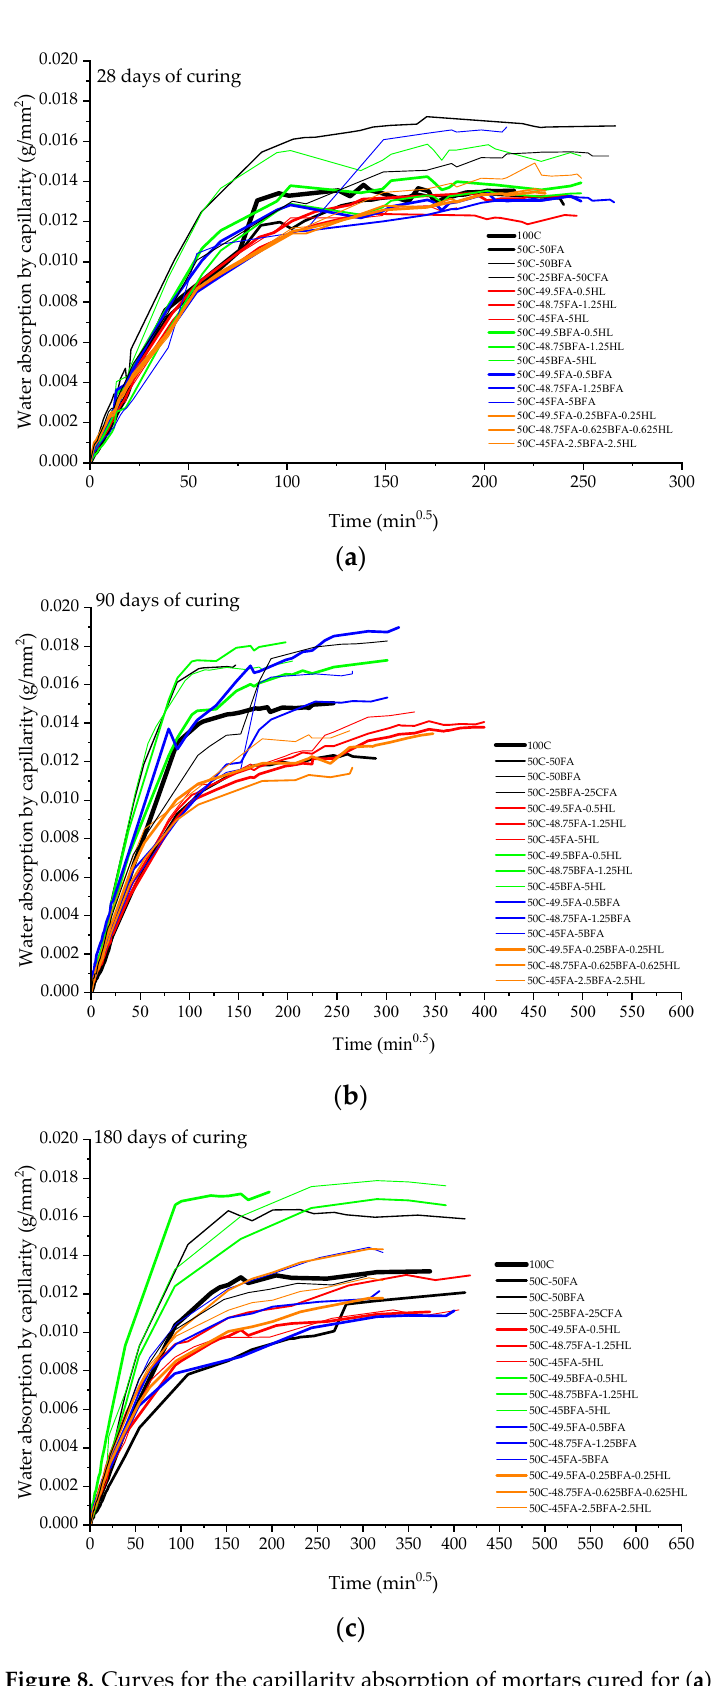
Figure 8. Curves for the capillarity absorption of mortars cured for ( a ) 28, ( b ) 90, and ( c ) 180 days of curing.